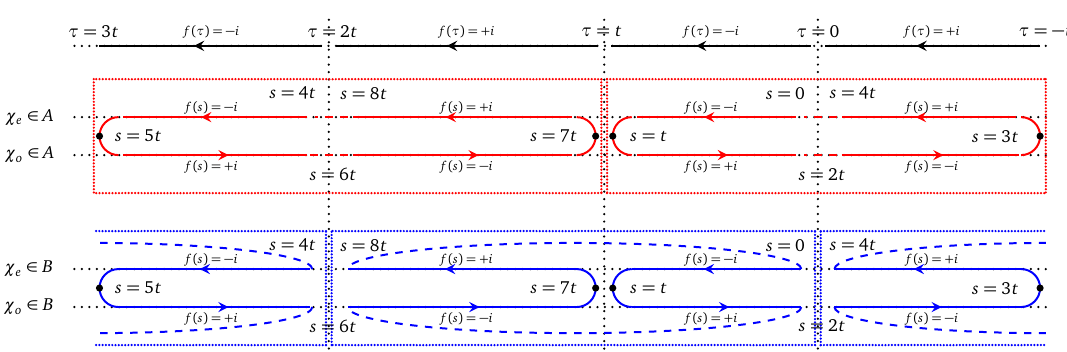
Figure 2: Time contour (solid red and blue lines) parameterized by s on the domain C s ∈ [ 0,4 nt ) used in Eq. (14), which combines the n replicas. The boundary conditions are shown by the dashed lines. The contour inside a blue box defines the Majorana fields of subsystem B in one replica, while the contour inside a red box defines the Majorana fields shifted by the twist field (See Appendix B). f ( s ) = ± i indicates the direction of the real-time evolution (forward / backward) on the contour for χ ( s ) . The original time parameterization by τ ∈ [ 0,2 nt ] is also shown (solid black line) for comparison (See Appendix